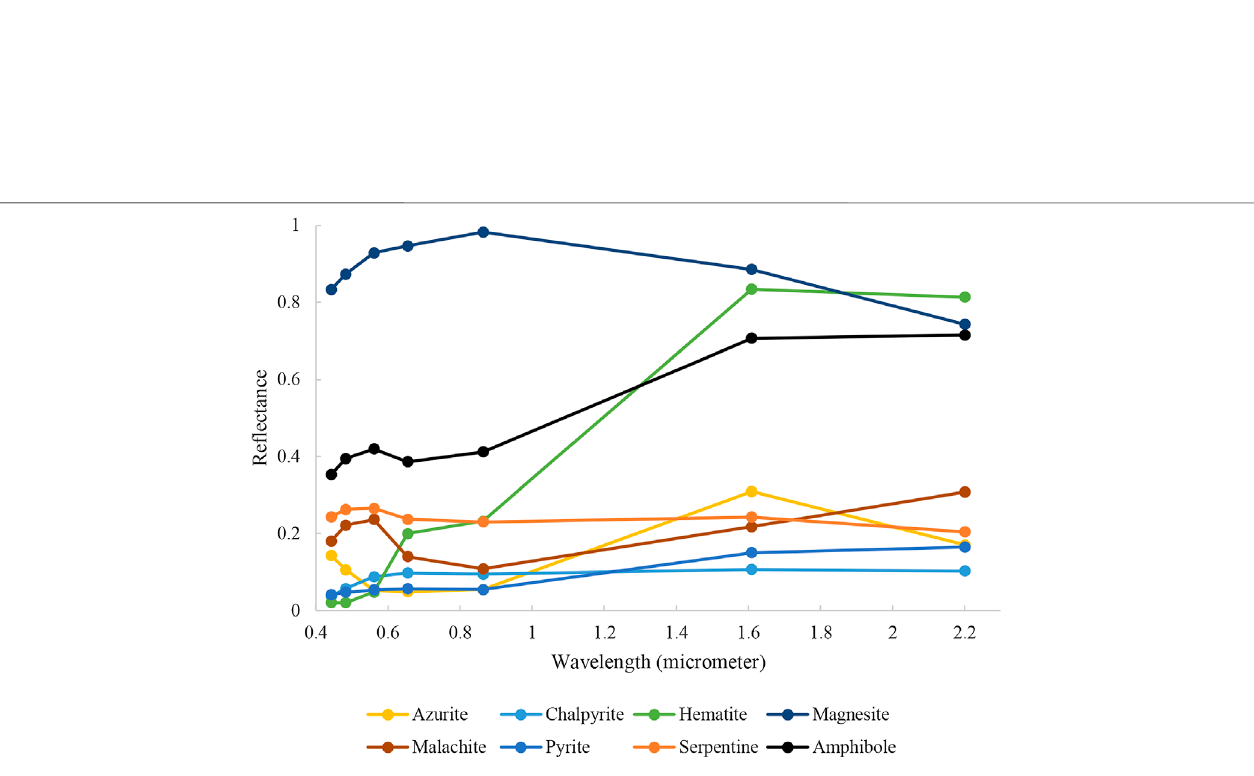
Frontiers in Earth Science |